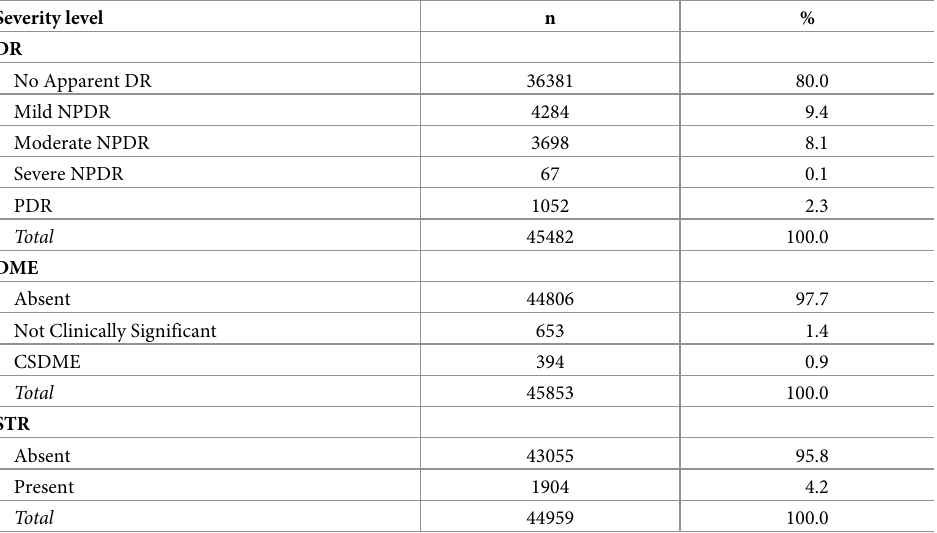
Table 2. Numbers (n) and percentages (%) of IHS-JVN patients by level of DR and